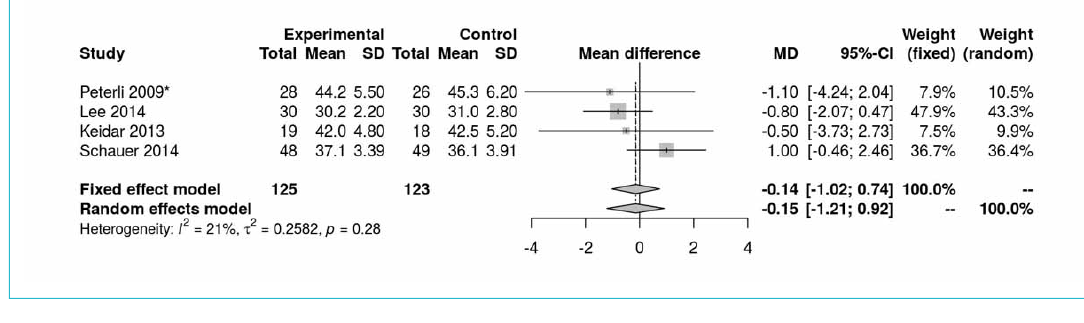
Figure S6b: Body mass index (BMI) at 24 months (analysis of studies including only patients with type 2 diabetes).